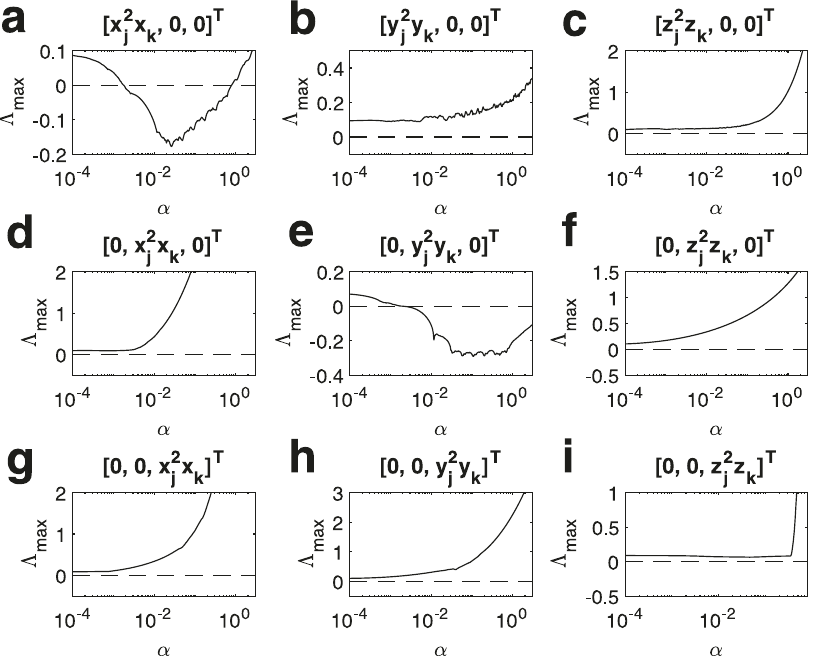
Fig. 4 Synchronization in simplicial complexes of Rössler oscillators, in the case of natural coupling. The Master Stability Function is here calculated taking into account several coupling functions. a h ð 1 Þ ð x j Þ ¼ ½ x 3 j ; 0 ; 0 (cid:3) T and h ð 2 Þ ð x j ; x k Þ ¼ ½ x 2 j x k ; 0 ; 0 (cid:3) T , b h ð 1 Þ ð x j Þ ¼ ½ y 3 j ; 0 ; 0 (cid:3) T and h ð 2 Þ ð x j ; x k Þ ¼ ½ y 2 j y k ; 0 ; 0 (cid:3) T , c h ð 1 Þ ð x j Þ ¼ ½ z 3 j ; 0 ; 0 (cid:3) T and h ð 2 Þ ð x j ; x k Þ ¼ ½ z 2 j z k ; 0 ; 0 (cid:3) T , d h ð 1 Þ ð x j Þ ¼ ½ 0 ; x 3 j ; 0 (cid:3) T and h ð 2 Þ ð x j ; x k Þ ¼ ½ 0 ; x 2 j x k ; 0 (cid:3) T , e h ð 1 Þ ð x j Þ ¼ ½ 0 ; y 3 j ; 0 (cid:3) T and h ð 2 Þ ð x j ; x k Þ ¼ ½ 0 ; y 2 j y k ; 0 (cid:3) T